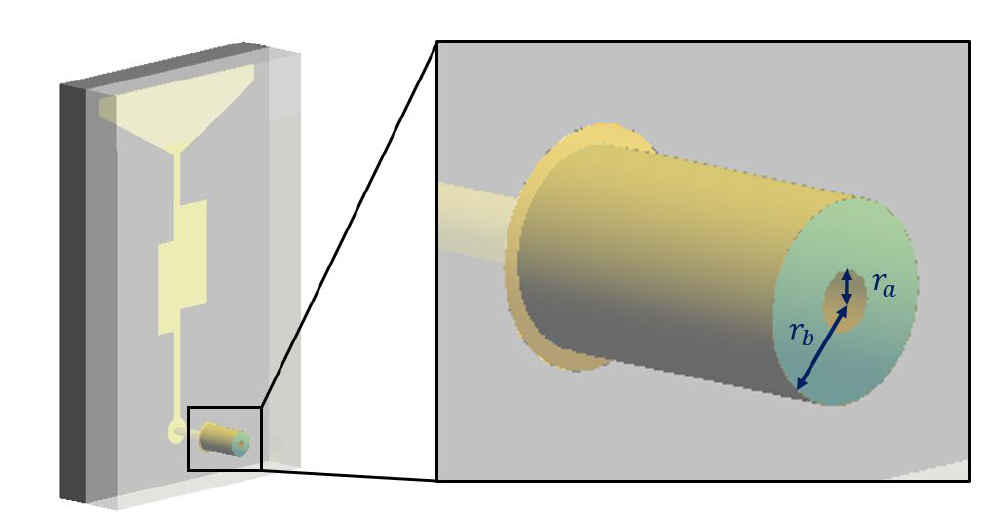
Figure 2. Whole model of antenna with closeup on the coaxial cable port.